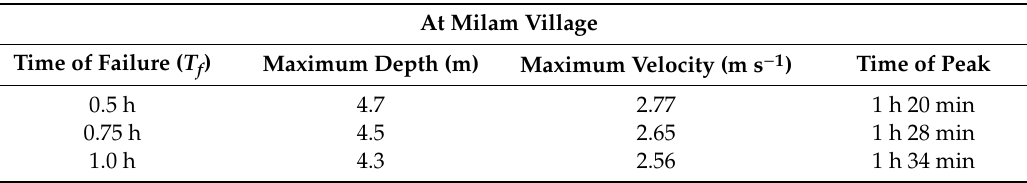
Table 4. Hydraulic properties of potential GLOF at Milam village for varied moraine-failure time.